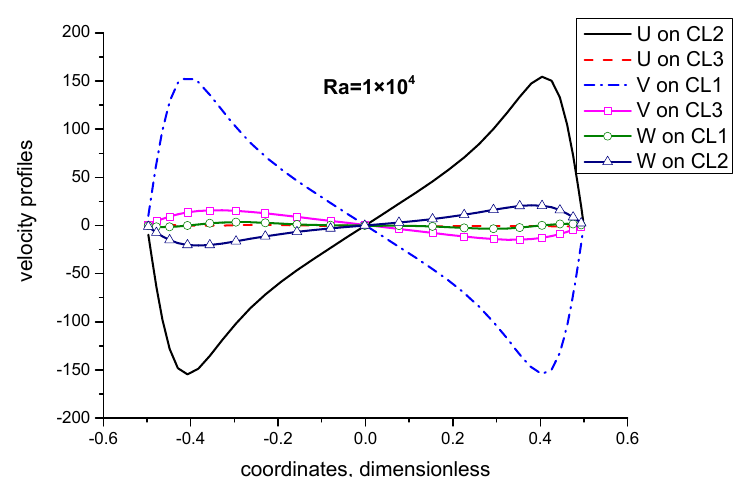
Figure 15. Velocity profiles on the center lines shown in Figure 14 for Case 1.